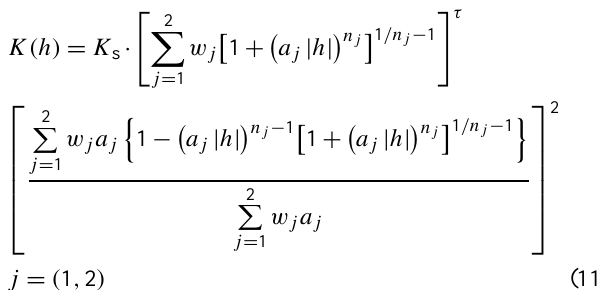
Close to the EC station a pit was dug down to 150 cm.